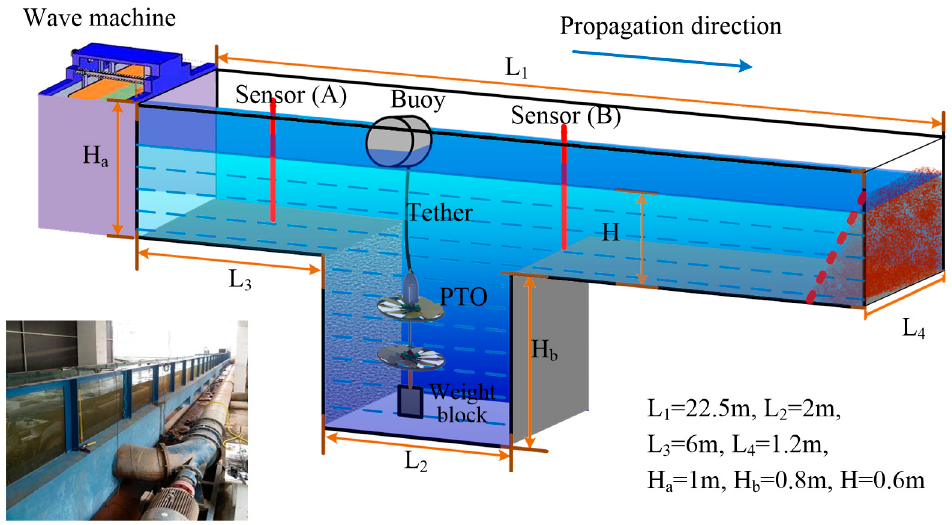
Figure 11. Experimental schematic.